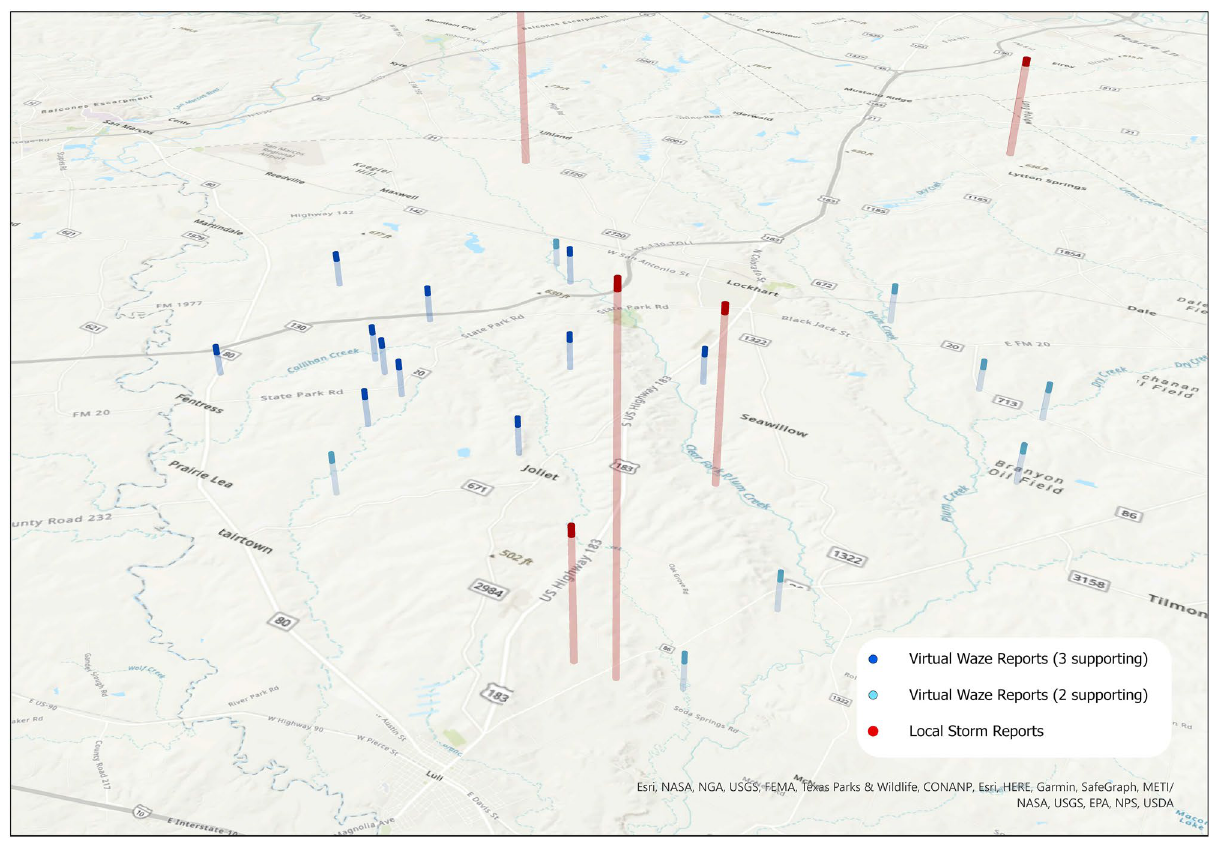
Figure 5. VWRs reported flooding to the South of Austin notably earlier than existing LSRs. The height of the bars represents time, with a difference of about 6.5 h between the VWRs (blue) and the LSR (red). In